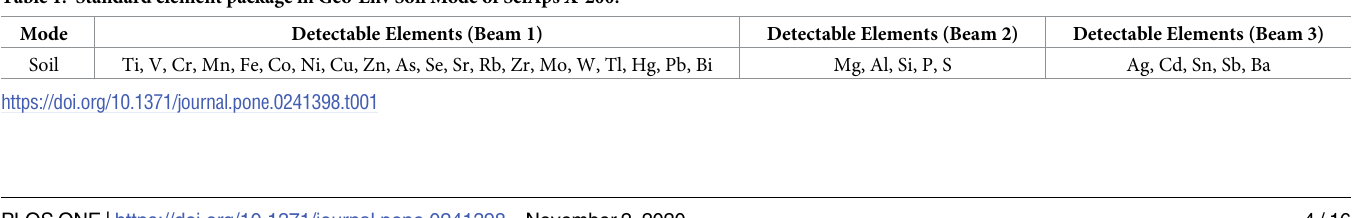
test of soil on site. The test meets the requirements of EPA method 6200. The detectable ele- ments are shown in Table 1. This stage can identify areas with potential pollution risks, which can realize qualitative and semi-quantitative analysis of samples. Second, soil samples were col- lected in key areas with potential pollution risks according to the result of first stage. After